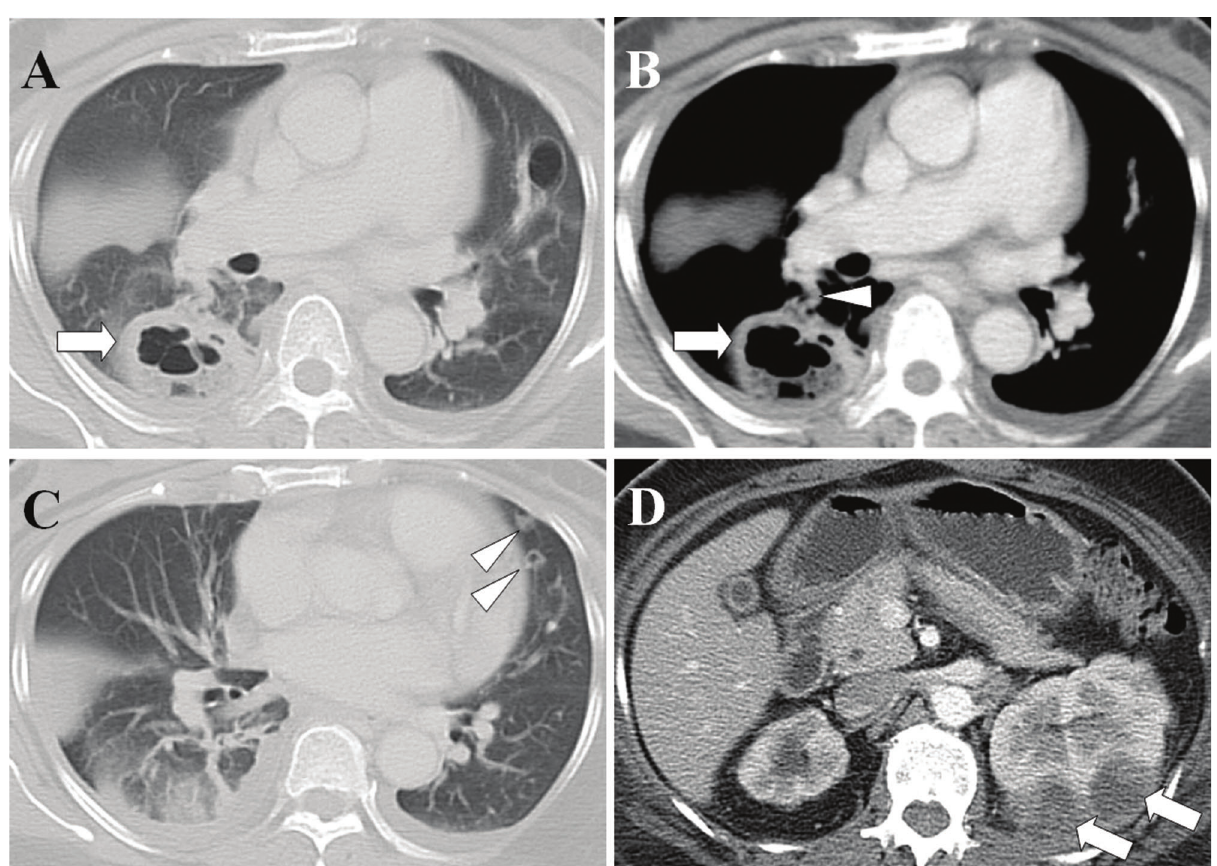
Figure 4 - Renal abscesses with septic pulmonary emboli. (A) A lung window of a cross-sectional CT scan shows a lung abscess with a diameter of 4.5 cm in the right lower lobe (arrow). (B) A contrast-enhanced CT scan (mediastinum window) in the same image plane shows a lung abscess (arrow) with a feeding vessel sign (arrowhead). (C) A lung window of a cross-sectional CTscan shows two nodules with cavities in the left upper lobe (arrowheads). (D) An abdominal CT scan shows left renal abscesses (arrows). The patient was a 52-year-old woman whose blood cultures were positive for Escherichia coli